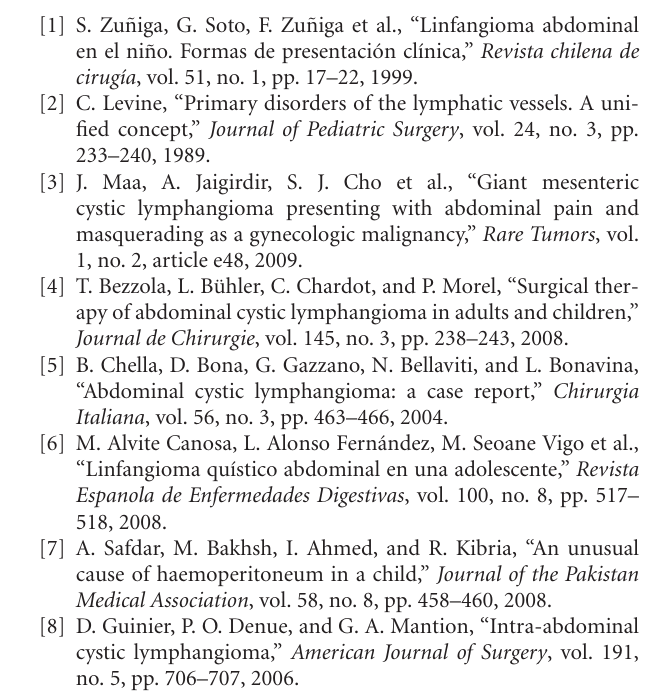
the heightened tension caused by the blood contained, so that allowed full removal. Cystic Lymphangioma should be considered as a possible cause of massive abdominal